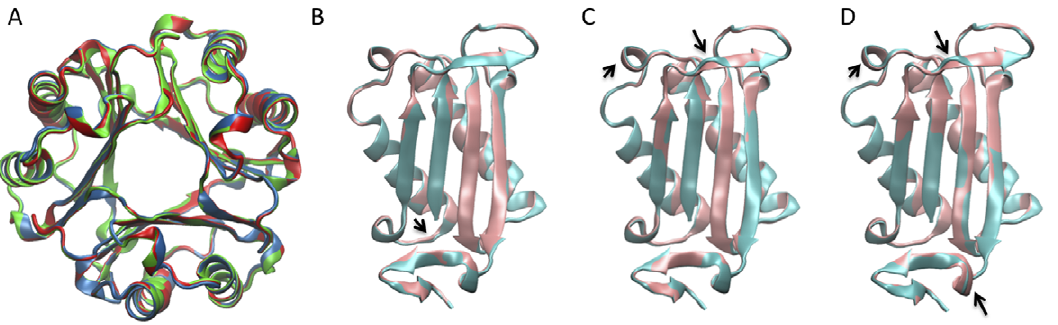
Figure 5. X-ray crystallography demonstrates that the three-dimensional structure of Leu46 mutants is very similar to the wt protein. (A) Overlay of crystal structures of L46F (blue) L46A (green) and L46G (red). (B, C, D) Secondary structure disruptions induced by the Leu46 mutants are shown by superimposition of the wt human and L46F (B), L46A (C) and L46G (D) MIF monomers. Wt and Leu46 mutant monomers are represented in pink and cyan respectively. Black arrows highlight the structural changes induced in the Leu46 variants.